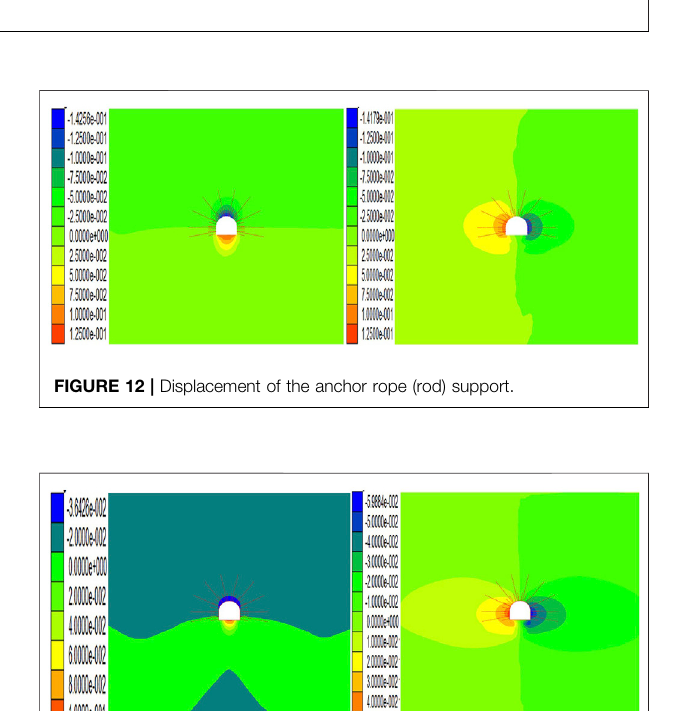
FIGURE 11 | Plastic zone by different ways of supporting.